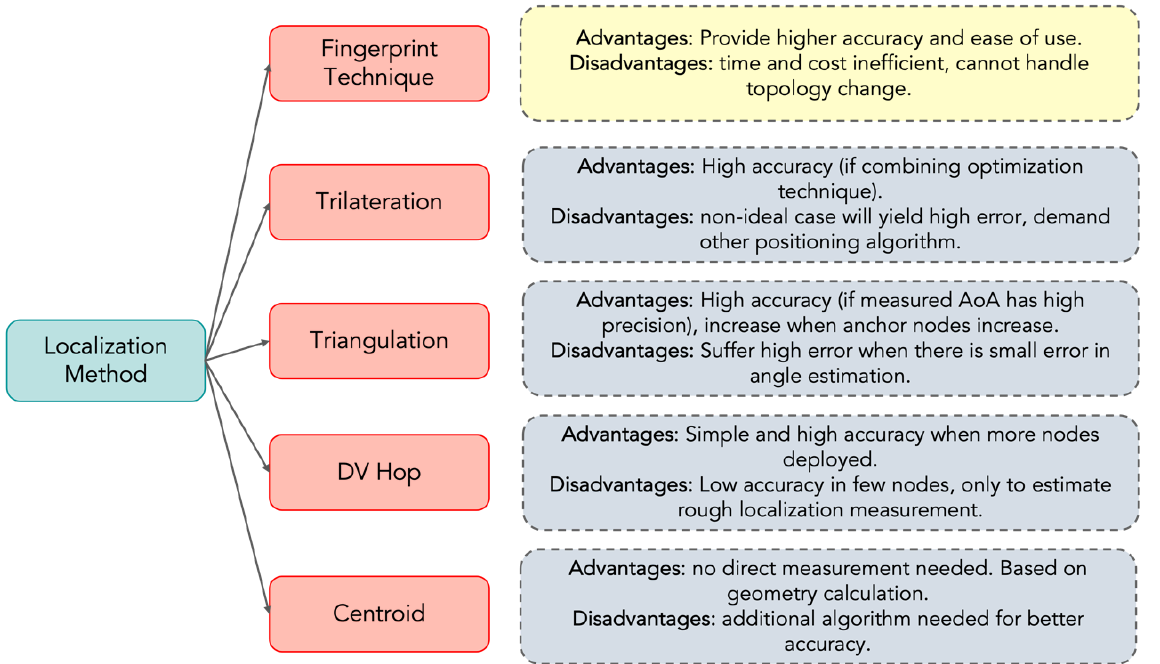
Figure 2. Localization